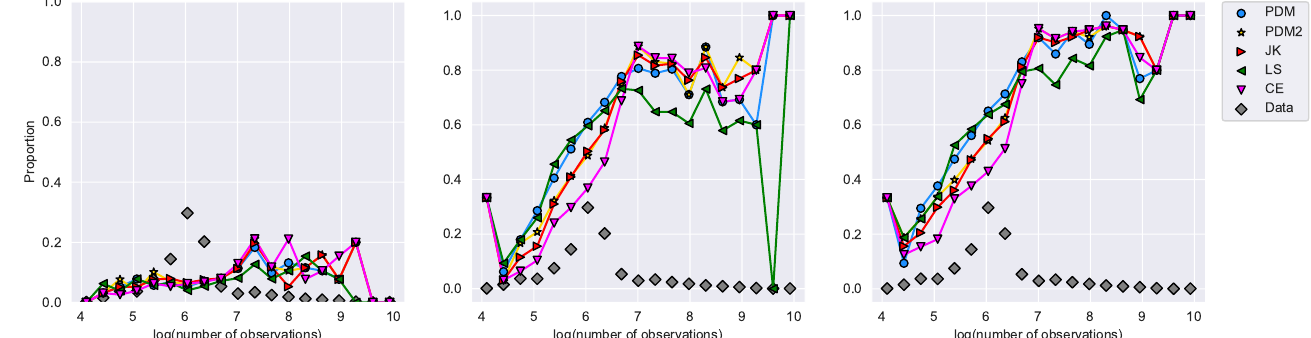
Figure 6. The comparison of different period finding algorithms considering the different number of observations for the step size defined in Equation (3) with A = 10. The criterion for comparison is the proportion of asteroids having a successful periodic recovery. From left to right, the three plots are for different δφ max = 85/50,850/50 and 8500/50. The gray diamonds indicate the proportion of asteroids at the corresponding number of observations in our data set.